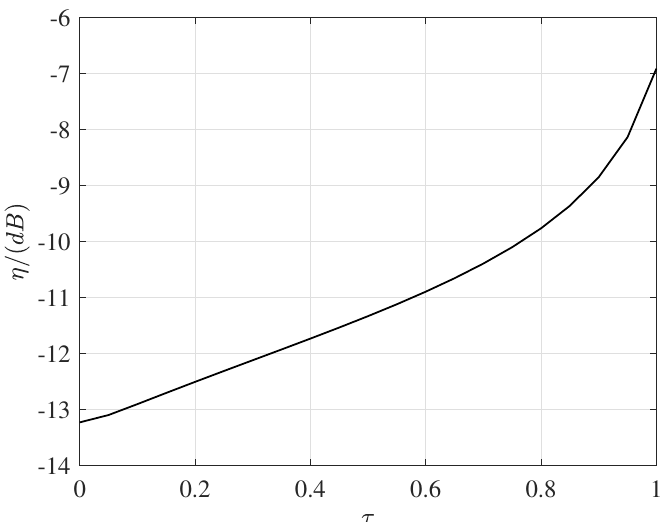
Figure 10. The NMSE of the sound pressure η at controlled points. The reverberation time RT 60 = 200 ms and the control filter length J = 400.